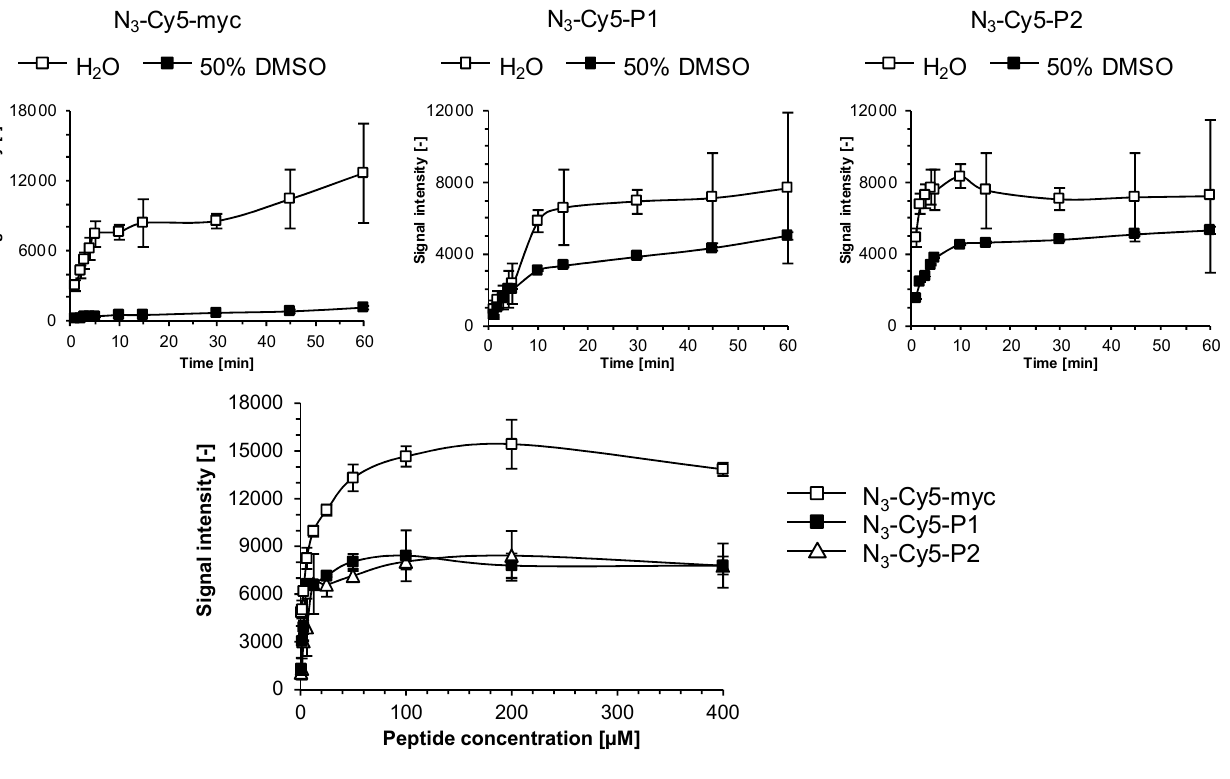
Figure 4. Reaction kinetics of azido-functionalized peptides to ADIBO-modified glass slides. 1 μ L of peptides N H O:DMSO at a 1:1 ratio were deposited and allowed react for the indicated time. 2 Fluorescence signals were recorded at λ = 635 nm after slides washing ( top